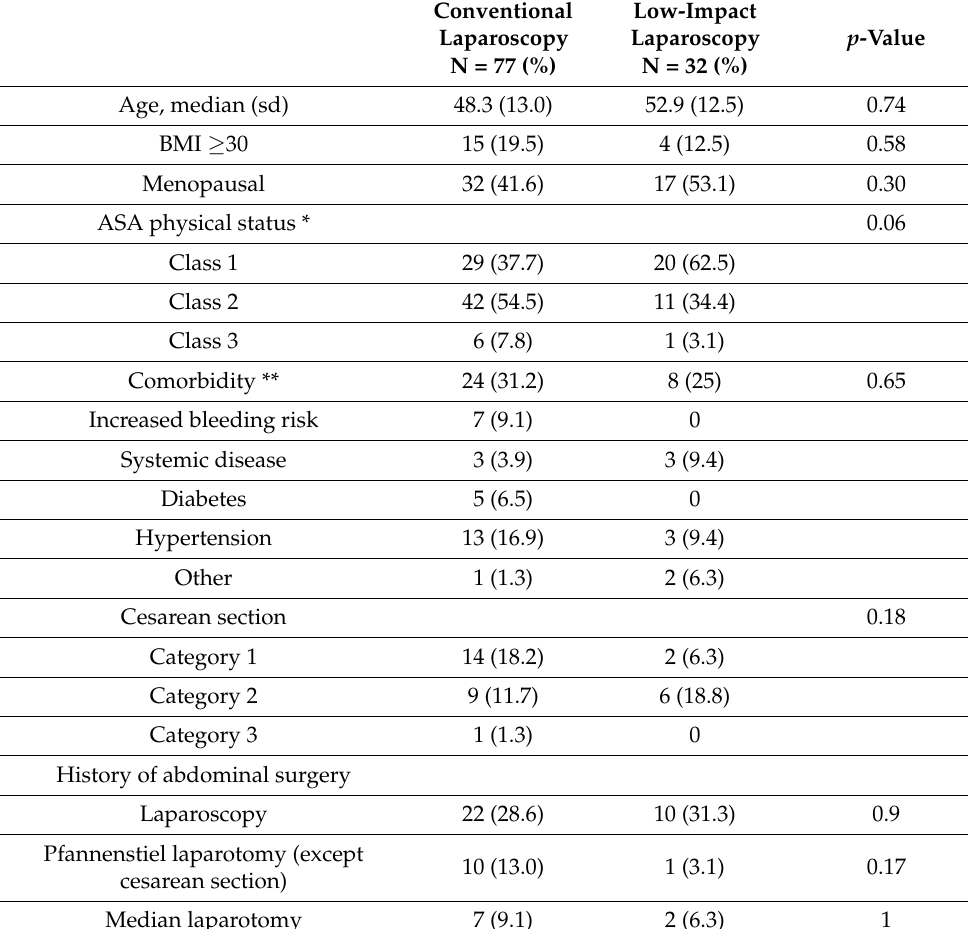
Table 1. Main patient characteristics.